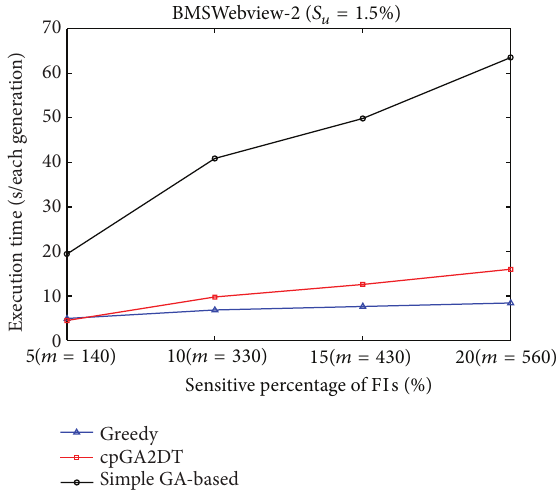
Figure 11: Comparisons of execution time at various minimum support thresholds for BMSWebview-1 database.